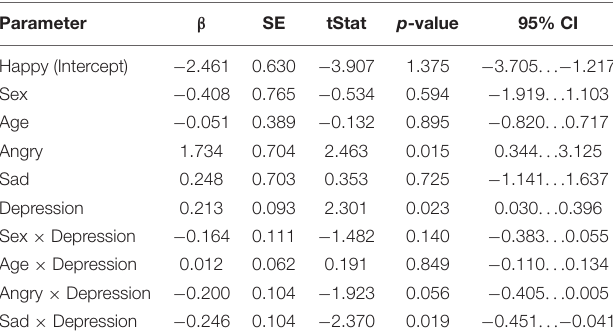
TABLE 2 | Results of the linear mixed-effects regression model (DF = 162) in the early time window (80–120 ms).